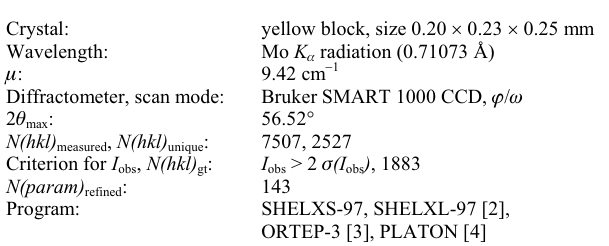
Table 1. Data collection and